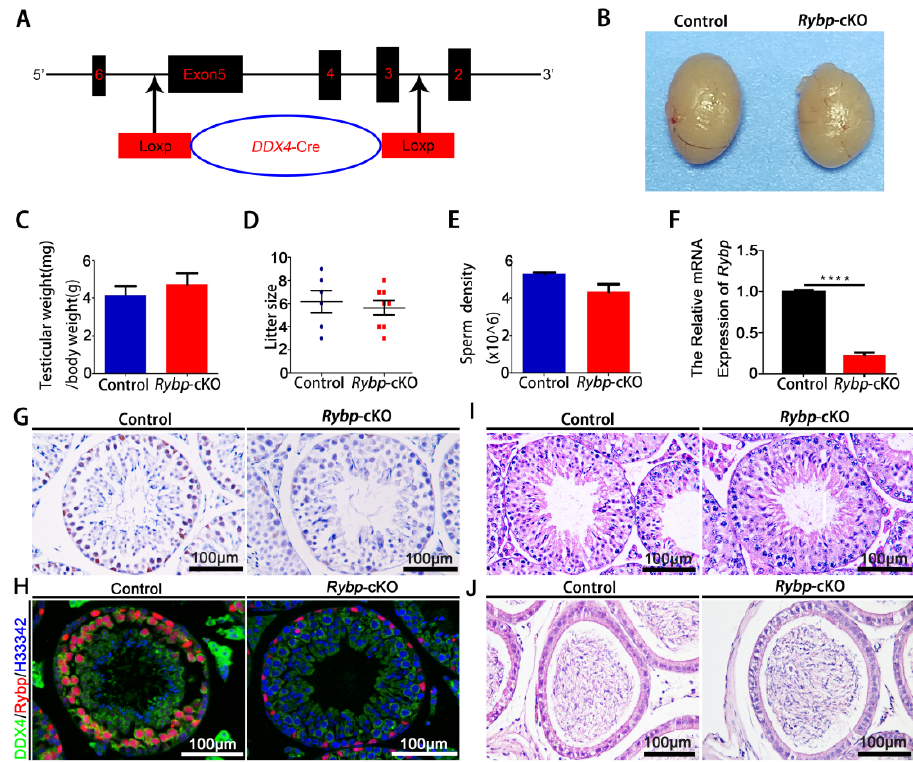
Figure 3. Germ-cell-specific Rybp -knockout mice were fertile. ( A ) Schematic diagram of Ddx4-Cre + ; Rybp flox / flox ( Rybp -cKO) mice generated using Cre–Loxp technology with exons 2–6. ( B ) Representative images of testes from three-month-old male control and Rybp -cKO mice. ( C ) Ratios of testes to body weight of three-month-old male control and Rybp -cKO mice. ( D ) Comparisons of litter size from three-month-old male control and Rybp -cKO mice. ( E ) Comparisons of sperm density from male control and Rybp -cKO mice. ( F ) Quantification of Rybp mRNA expression in testes from three-month-old male control and Rybp -cKO mice. Data were analyzed using mean ± SEM for three mice per genotype. **** indicates a significant difference of p < 0.0001. ( G ) Immunohistochemical staining for Rybp in cross-sections of testes from three-month-old male control and Rybp -cKO mice. Scale bar, 100 μm. ( H ) Coimmunofluorescent staining for Rybp and DEAD-box helicase 4 (DDX4) (a germ-cell marker) in cross-sections of testes from three-month-old male control and Rybp -cKO mice. Scale bar, 100 μm. ( I ) Representative images of hematoxylin and eosin (H&E)-stained testes from three-month-old male control and Rybp -cKO mice. Scale bar, 100 μm. ( J ) Representative images of H&E-stained cauda epididymides from three-month-old male control and Rybp -cKO mice. Scale bar, 100 μm. Data were analyzed using mean ± SEM for three mice per genotype.